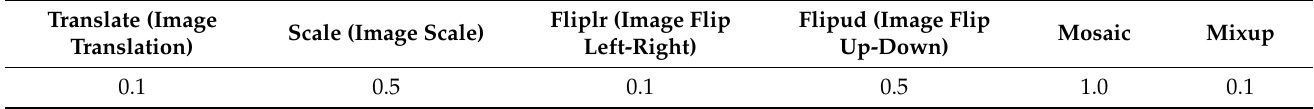
Table 2. Hyperparameter settings of data enhancement.